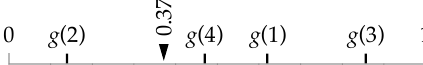
Figure 5. For this example, we assume that only genotype functions with the decoded indices 1, 2, 3, and 4 are eligible for a given output type. Consequently, the value provided by the germinal vector is substituted by its closest number among the available golden values g ( 1 ) , g ( 2 ) , g ( 3 ) , and g ( 4 ) ; 0.372 is replaced by g ( 4 ) = 0.472136, a permanent pointer to a function. This transformation ensures the rendering of the exact same specimen, regardless of working with an extended function library in the